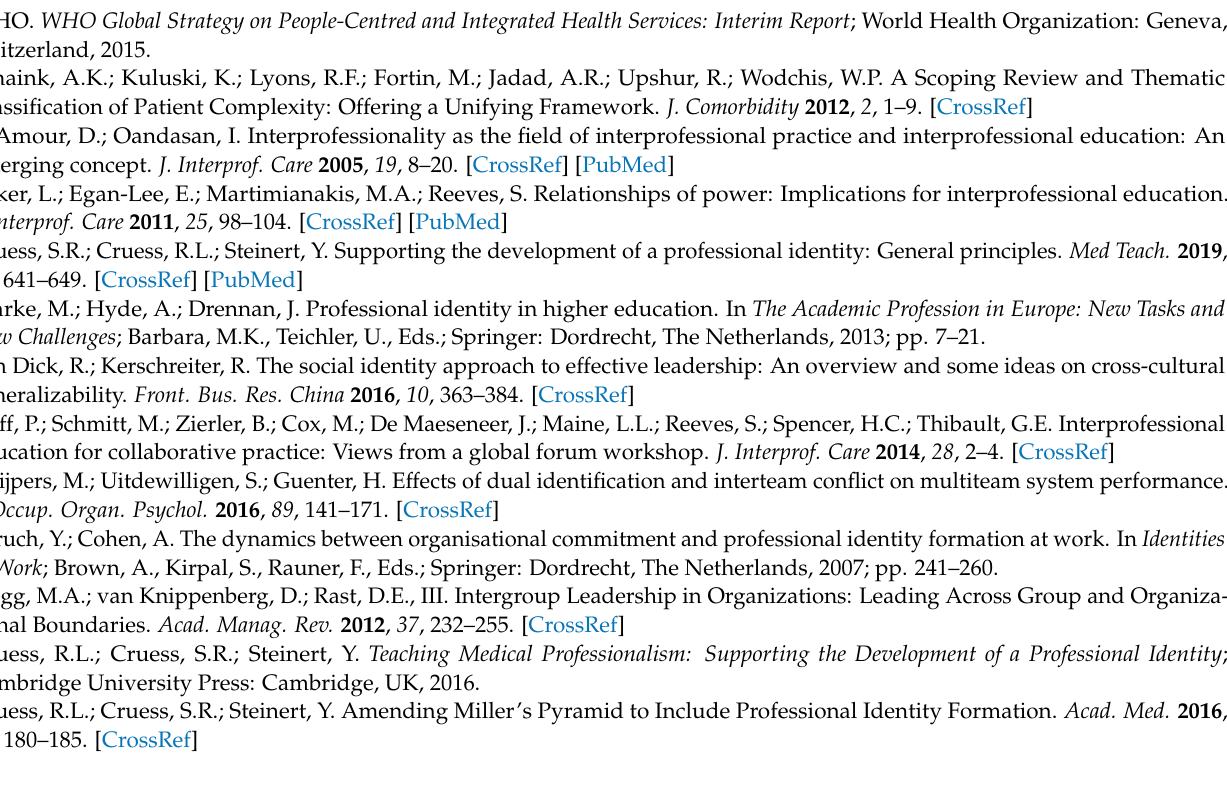
Table S2: Reporting Checklist; Table S3: Search strings; Table S4: List of excluded studies; Table S5: Data-extraction tables; Table S6: Code book. Refs. [31–103] are cited in the supplementary